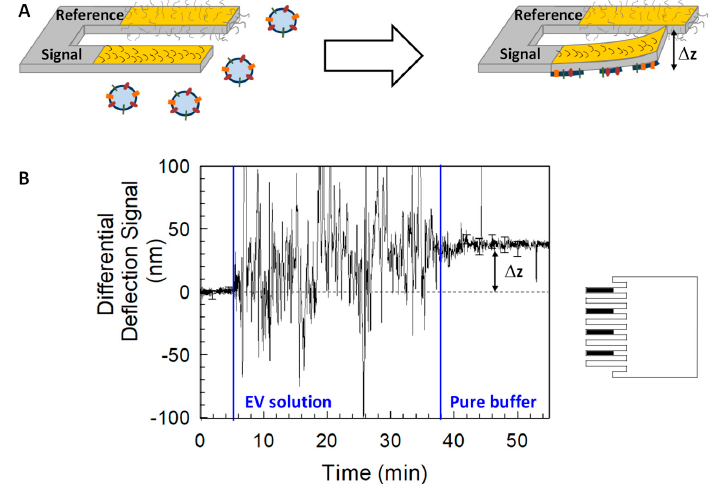
Figure 3. Static microcantilever (MC) experiments. ( A ) Scheme of MCs and their deflection due to the interaction between the EVs and their silicon bottom face; ( B ) MCs mean differential deflection driven by the interaction of the EVs with the MCs. The error bars represent the standard deviation of the mean.